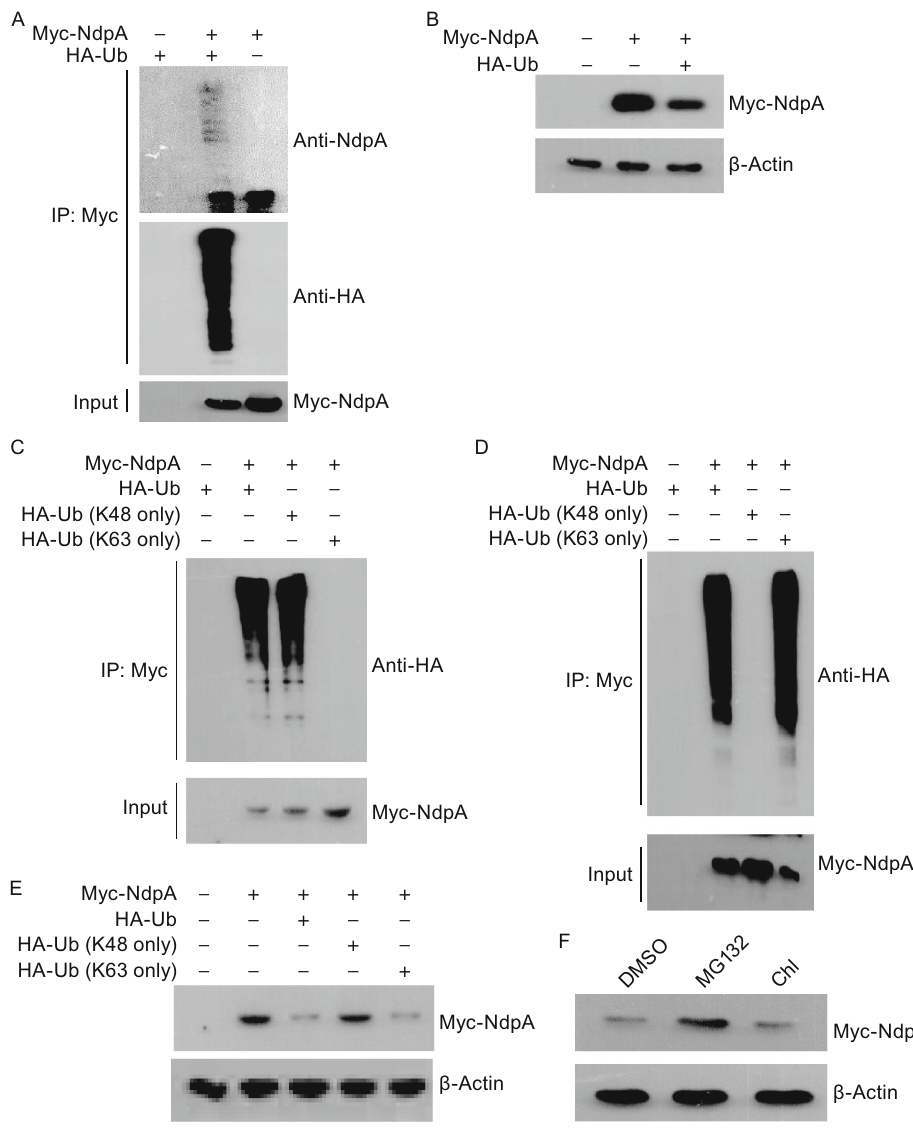
Figure 2. K . pneumoniae NdpA is degraded through the ubiquitin-proteasome pathway in host cells. (A) Ubiquitination assay of NdpA in vivo. HEK293Tcells were transfected with indicated plasmids, 24 h later, Myc-NdpA was immunuoprecipated with the gel- conjugated Myc antibody and immunoblotted with anti-HA and anti-NdpA antibodies. (B) Immunoblotting analysis of Myc-NdpA in the absence or presence of HA-Ub in HEK293T cells. (C) HEK293T cells expressing Myc-NdpA together with HA-Ub or Lys 48-linked polyubiquitylation (K48 only) or Lys 63-linked polyubiquitylation (K63 only) were subjected to the gel-conjugated Myc antibody and immunoblotted with HA antibody. (D) HEK293Tcells expressing Myc-NdpA together with HA-Ub or HA-Ub (K48R) or HA-Ub (K63R) were subjected to the gel-conjugated Myc antibody and immublotted with HA antibody. (E) A549 cells transfected with indicated plasmids were detected for NdpA protein by immunoblotting. (F) A549 cells expressing Myc-NdpA were treated with DMSO or 10 μ mol/L MG132 or 100 μ mol/L chroloquine (Chl) for 6 h, and then NdpA protein was detected by